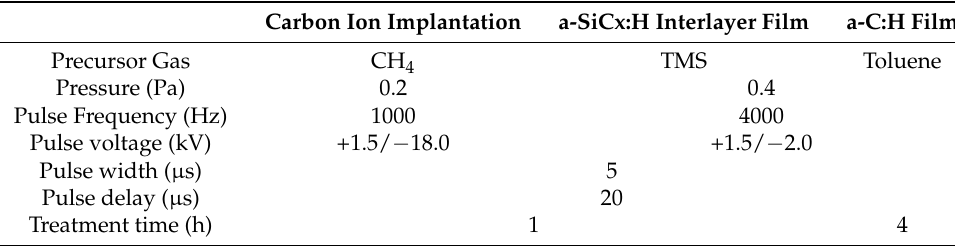
Table 1. Conditions of carbon ion implantation and film deposition.